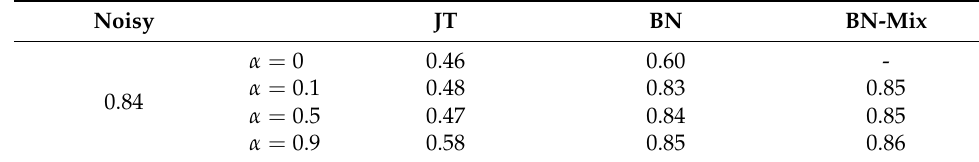
Table 4. The STOI metric for different architectures with different α .